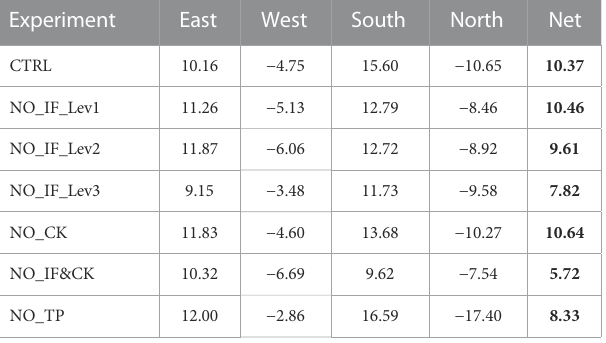
TABLE3The averageregional watervaporbudgets onJuly20(unit:10 7 kg s − 1 , positive inward and negative outward).